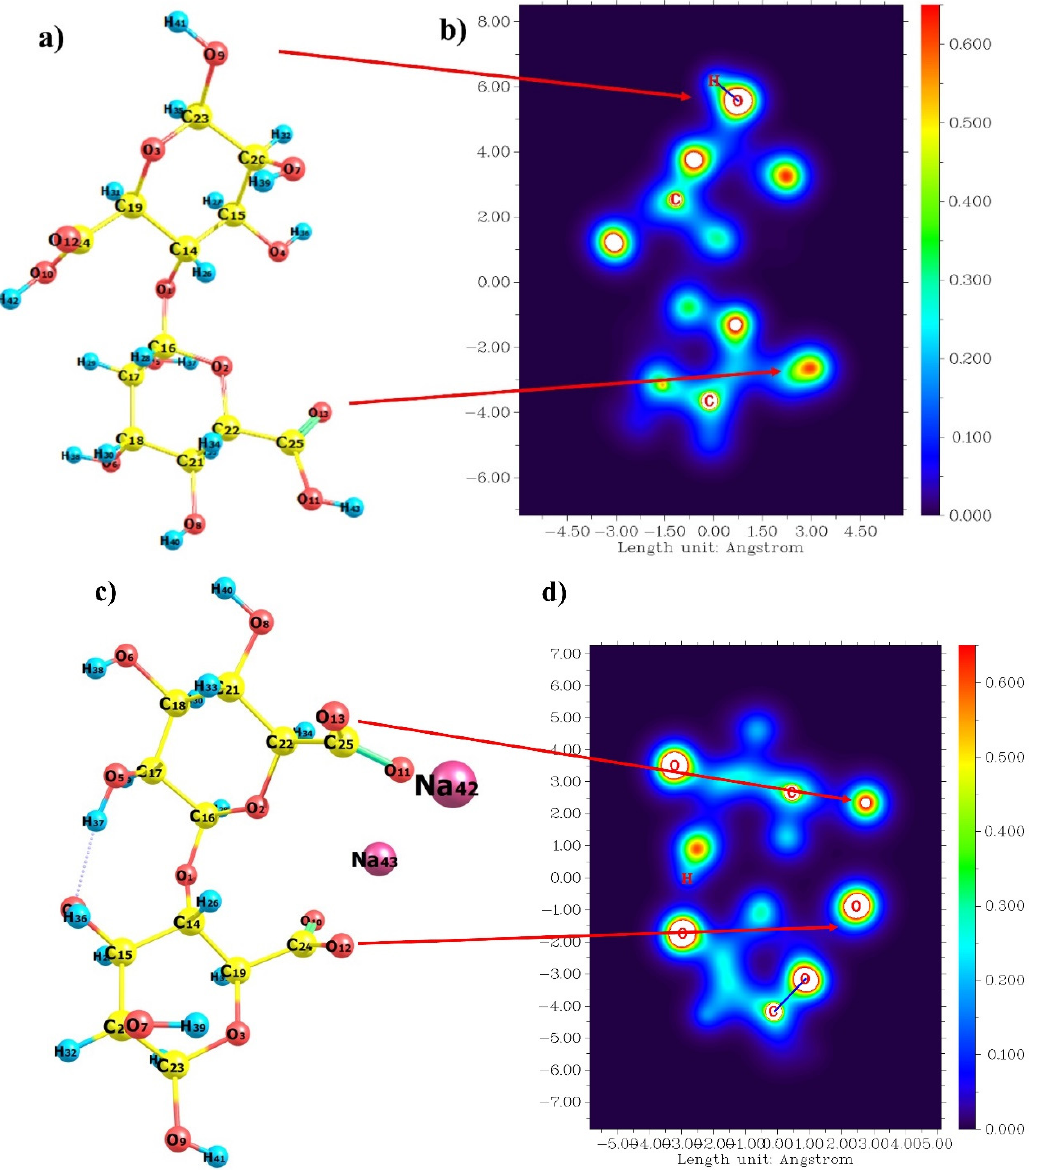
Figure 1. Optimized structure and molecular electrostatic potential of dimer alg ( a , b ), and dimer SA ( c , d